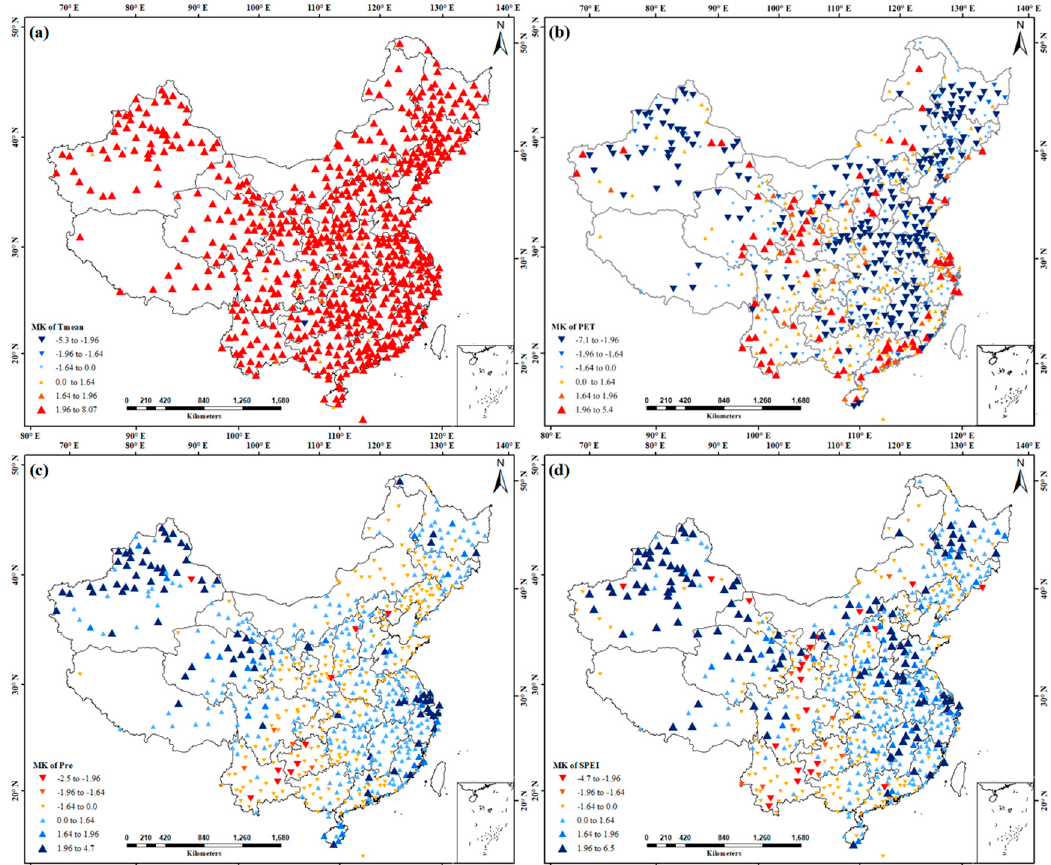
Figure 3. Spatial patterns of trends in the ( a ) annual mean air temperature ( T mean ), ( b ) potential evapotranspiration (PET), ( c ) precipitation (Pre), and ( d ) standardized precipitation evapotranspiration index (SPEI) from 1965 to 2017. Triangles of different sizes indicate trends of different magnitudes. MK, Mann–Kendall test.